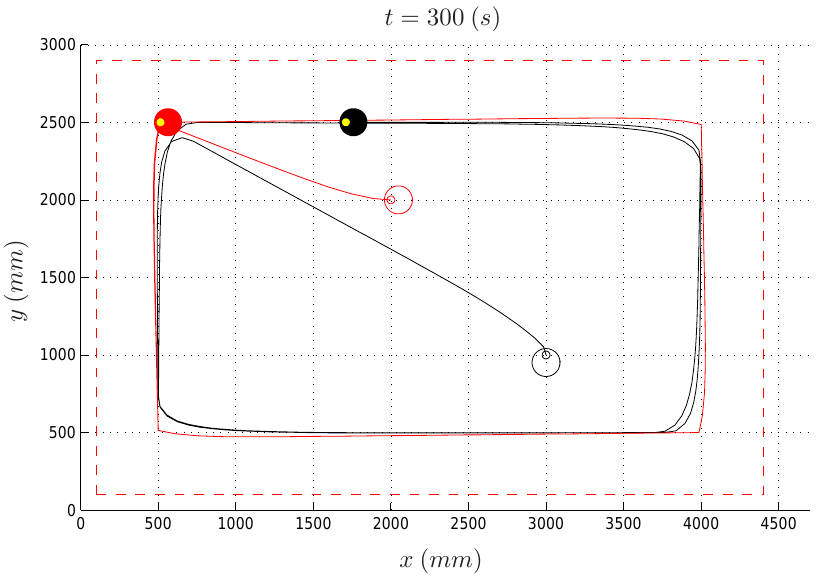
Figure 13. Pursuer-evader games, Algorithm 1: pursuer (black) and evader (red) with a PE speed ratio equal to 50% (simulated